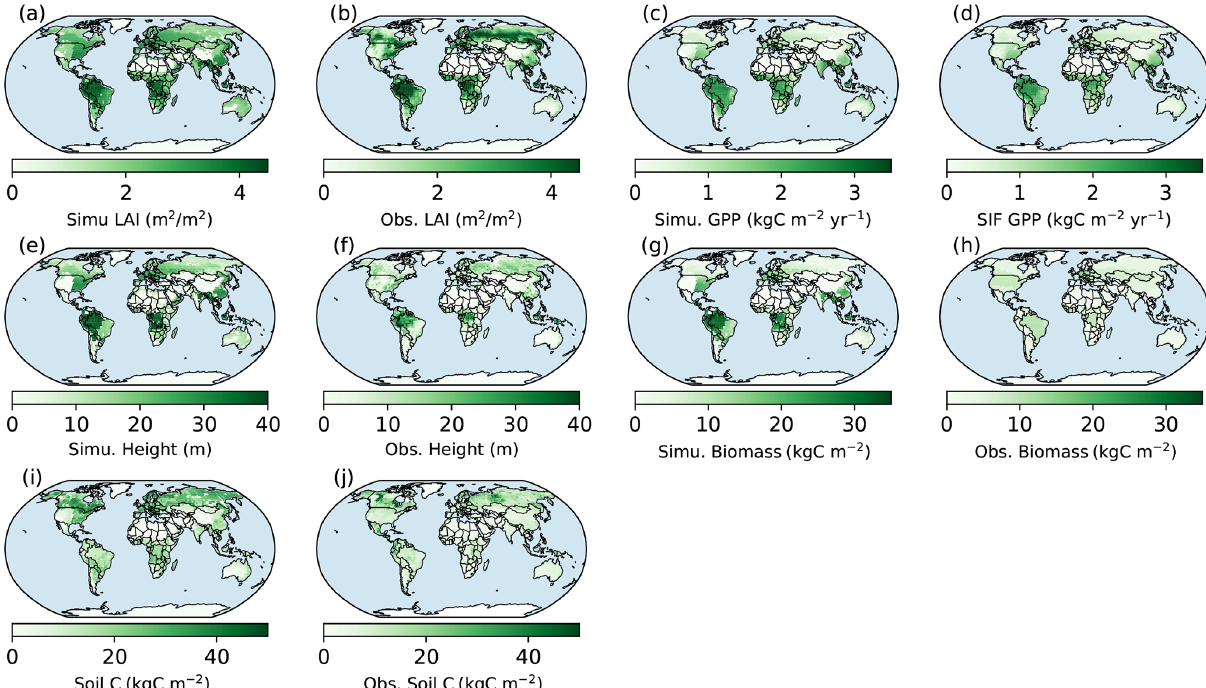
Figure 7. Spatial patterns of BiomeE (full demography) simulations and those from data. Obs. means different ways retrieved from observa- tions. Obs. LAI is from Ent vegetation data (MODIS LAI 2004; Ito et al., 2020; Tian et al., 2003). Obs. GPP is derived from solar-induced fluorescence (SIF) data with a machine learning approach (Alemohammad et al., 2017). The data are available from January 2007 to Decem- ber 2015. The tree height data are from spaceborne light detection and a ranging (lidar) global map of canopy height at 1km spatial resolution, as developed by Simard et al. (2011). Biomass data are from Hengeveld et al. (2015). Soil carbon data are from the FAO Harmonized World Soil Database (version 1.2), which was updated by Wieder (2014).